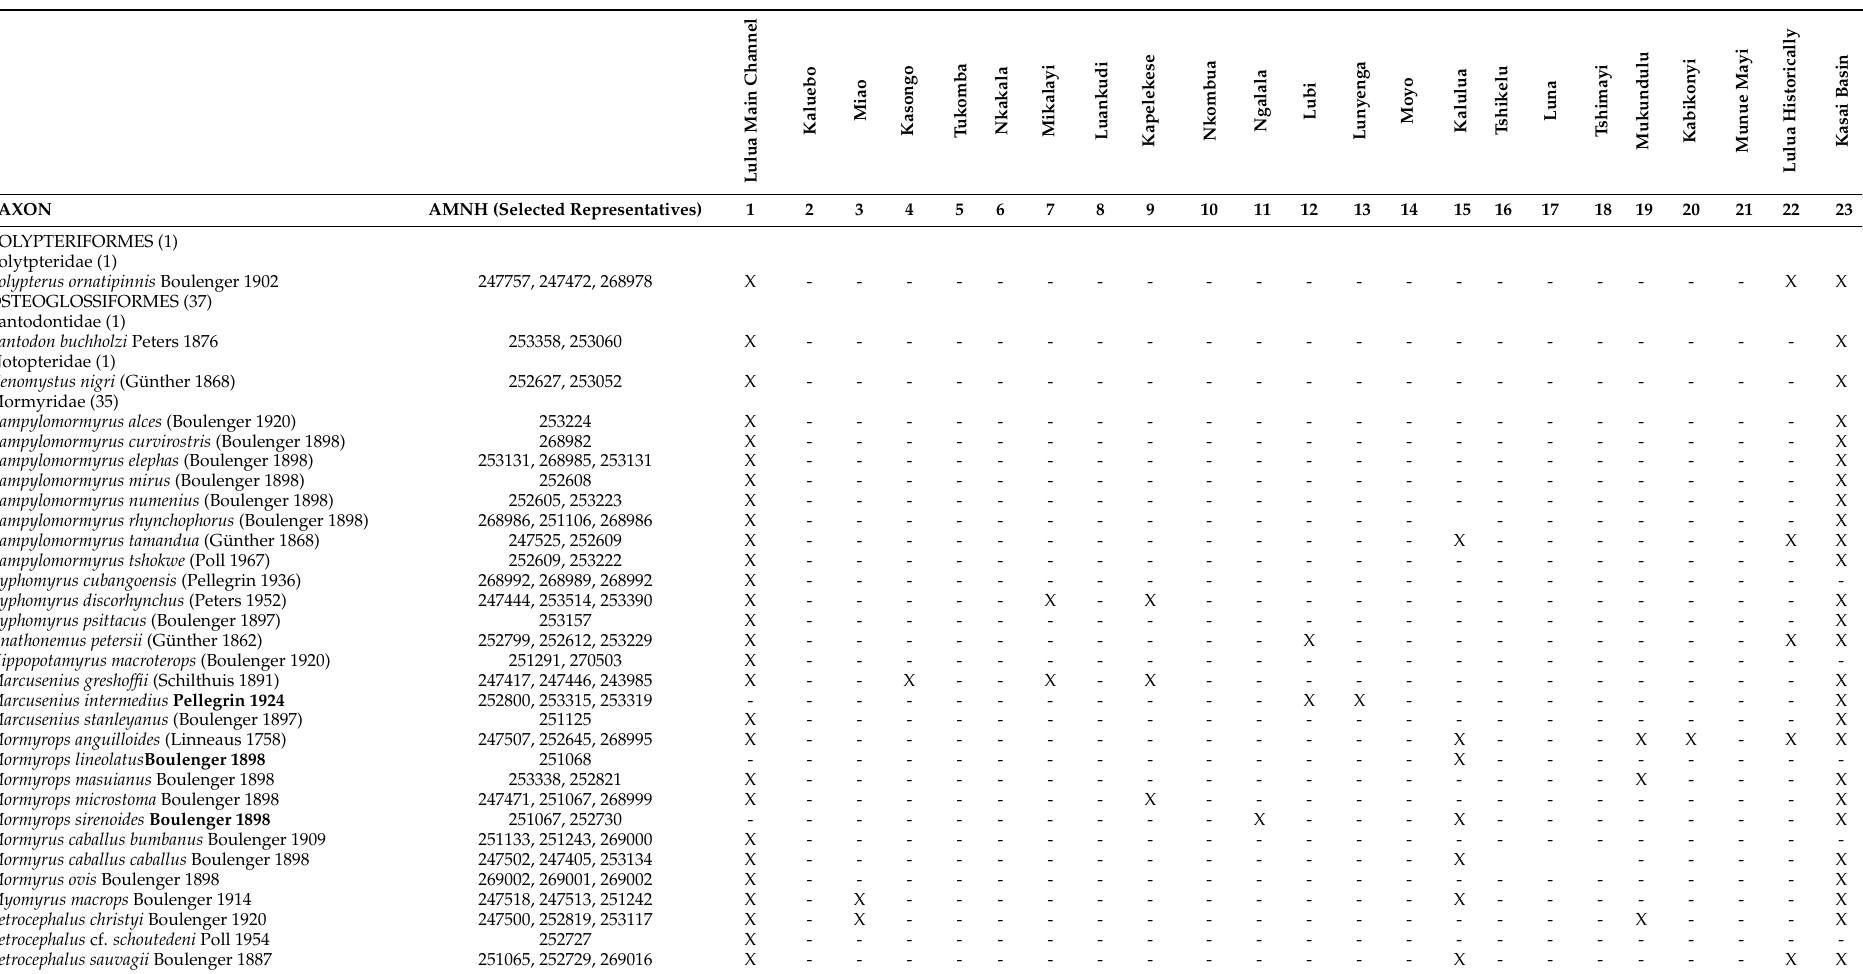
Table A2. List of species collected at sites in the main channel (lower Lulua) and tributaries. Sub-tributary species are listed in their respective tributaries. Species in bold type were collected only in tributaries. Numbers in parenthesis are species numbers. In columns 22 (Kasai) and 23 (Lulua historically), distribution data culled from [25,27,60,62,72–75] were used to indicate which Lulua species are known to occur in the Kasai ecoregion and which were not reported in the catchment prior to this